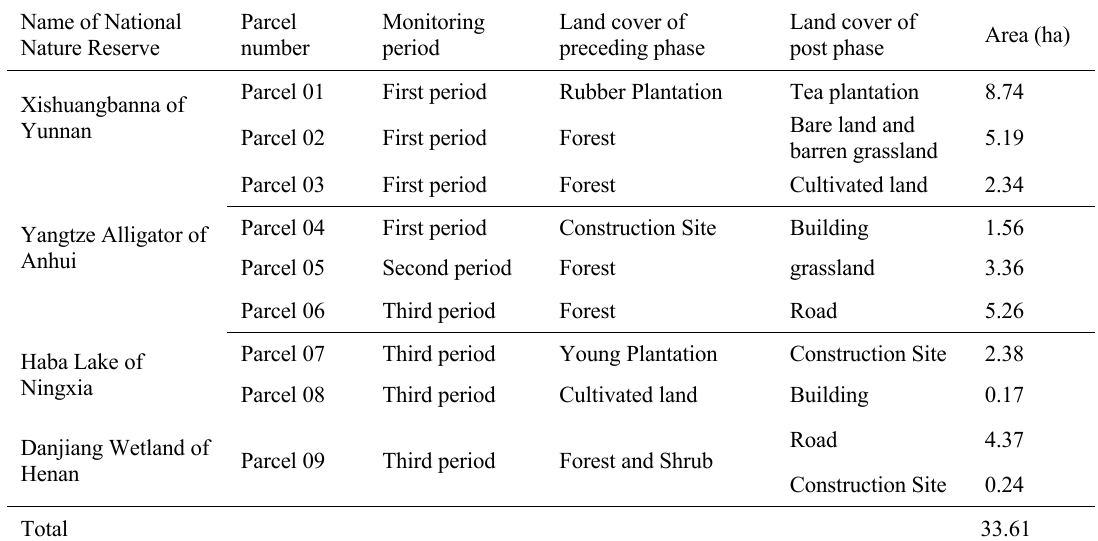
Table 1 Suspected illegal land cover changes related to human activities in typical national nature reserves of China in 2019 Name of National Nature